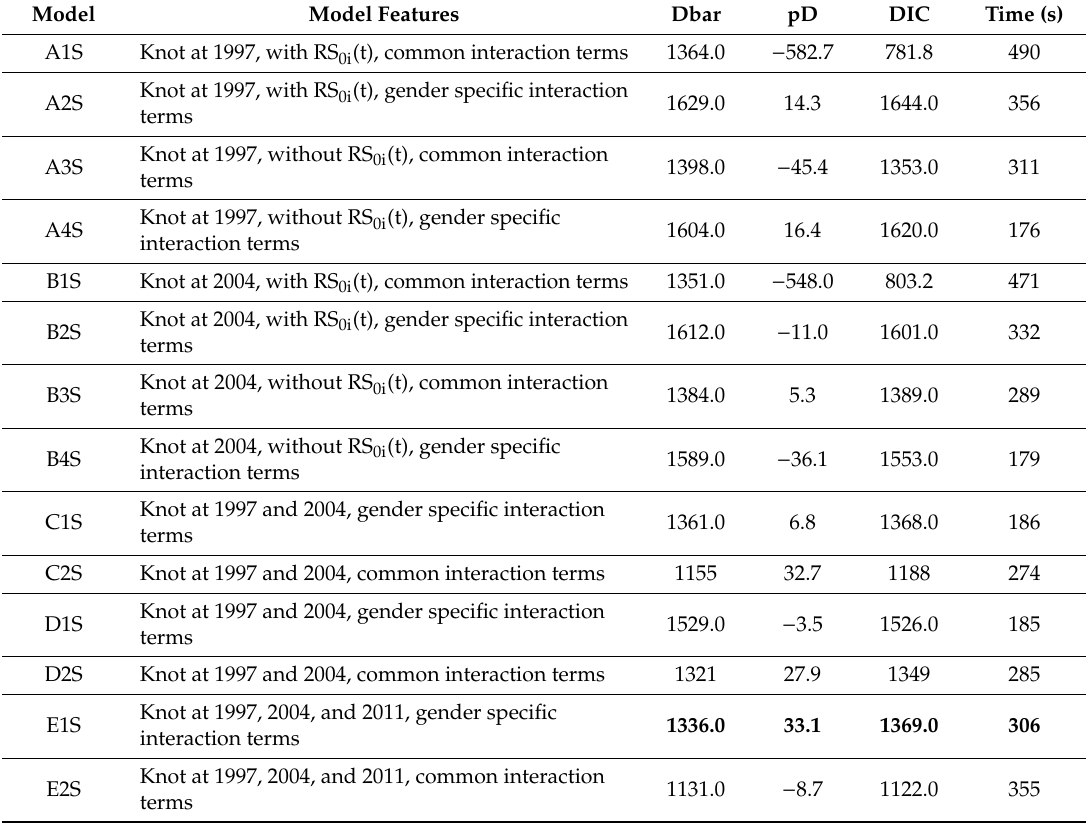
Table A2. Spatio-temporal SCM model